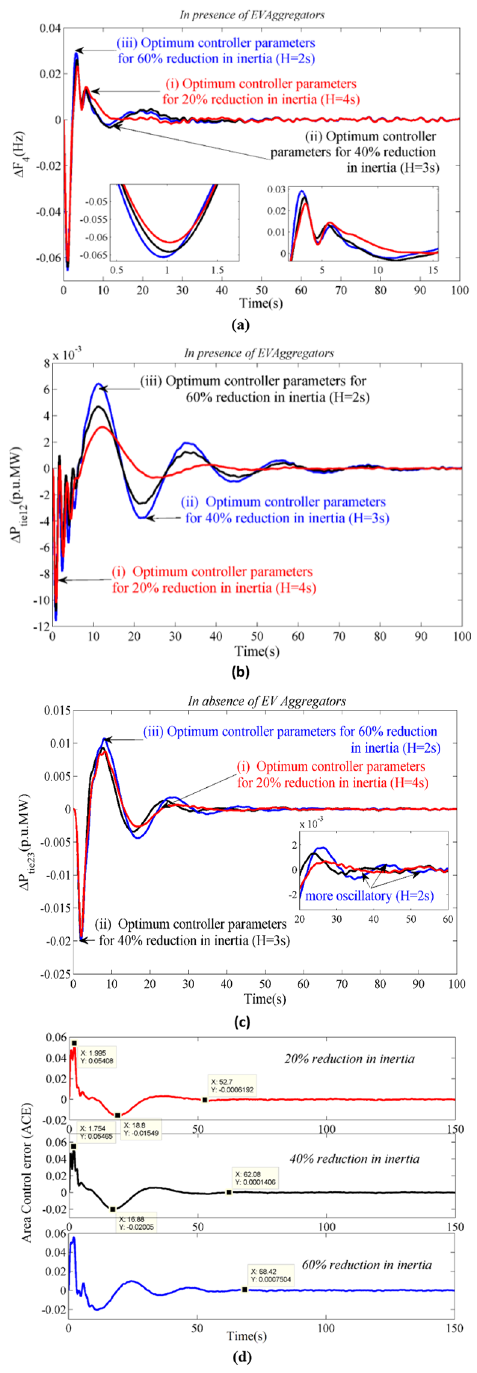
Fig. 5 Comparison of system dynamic responses due to outage of a thermal unit considering the effect of R, B. a Frequency deviation in area 4 in presence of EV aggregators. b Tie-power deviation in the line connecting area 1 and 2 in presence of EV Aggregators. c Tie-power deviation in the line connecting area 2 and 3 in absence of EV Aggregators. d Control signal in area 1 for 20%, 40% and 60% reduction in inertia respectively in presence of EV